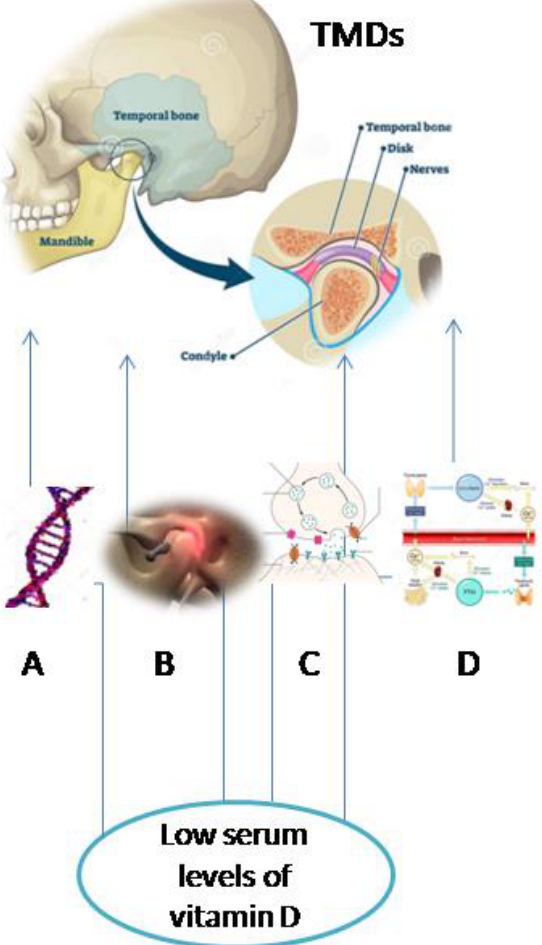
Figure 2. Possible pathways of interconnection between temporomandibular disorders and low levels of vitamin D (A — VDR gene polymorphism, B — inflammatory processes, C — neuroprotective function, and D — calcium and parathyroid hormone (PTH) metabolism).